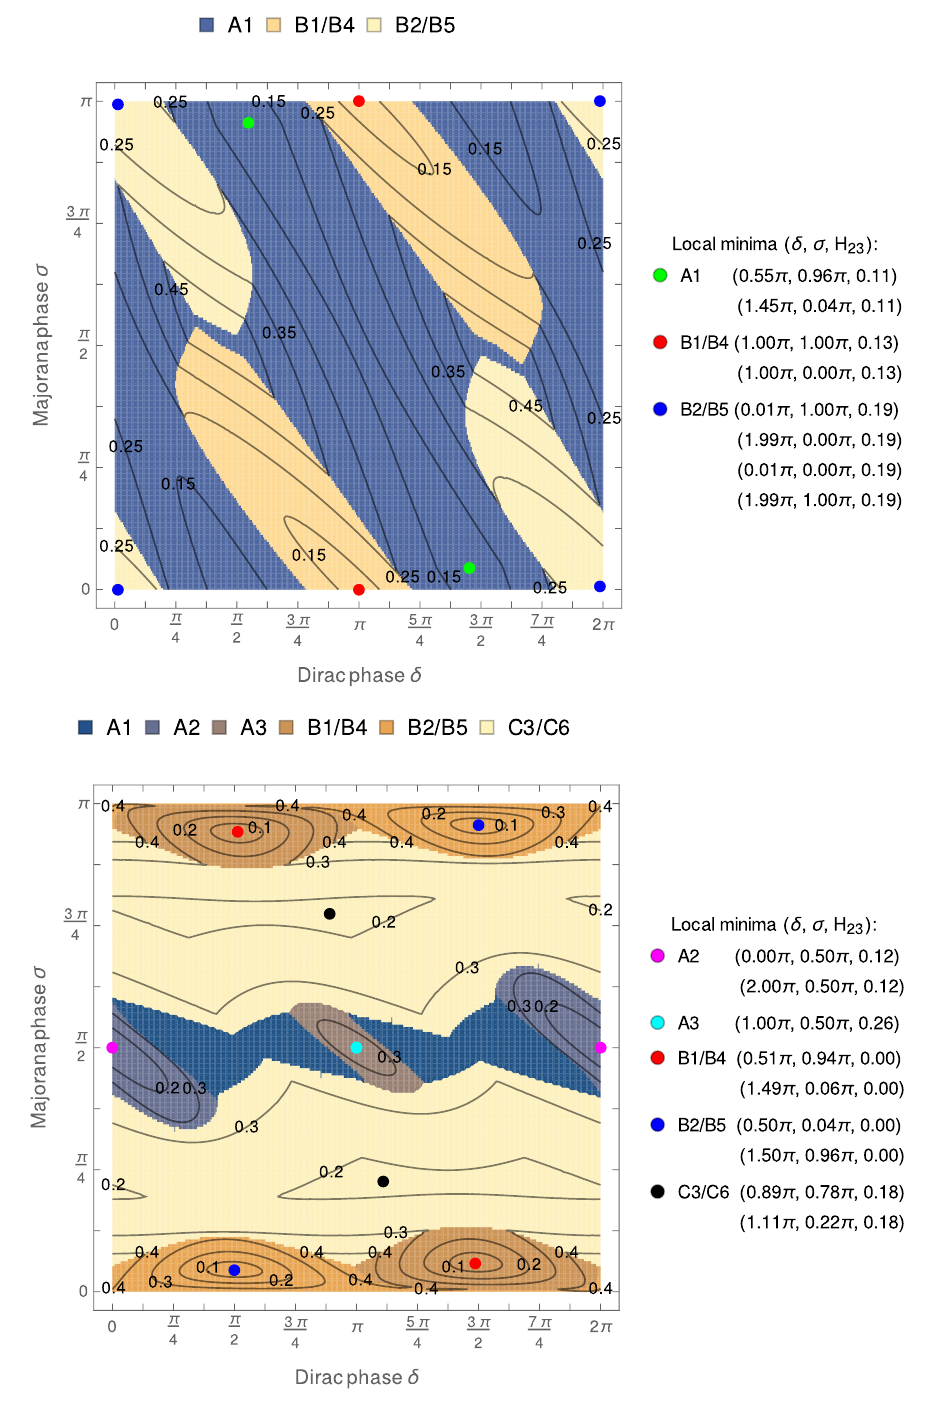
Figure 2 . Minimized hierarchy parameter H 23 as a function of the CP -violating phases (cid:14) and (cid:27) for normal (upper panel) and inverted neutrino mass ordering (lower panel) , see eq. (4.1). The contour lines represent the function values of H 23 in the ( (cid:14); (cid:27) ) plane, while the color shading indicates the corresponding (approximate) Yukawa textures according to eq. (2.14). The colored points mark the local minima of H 23 , see also table 2.